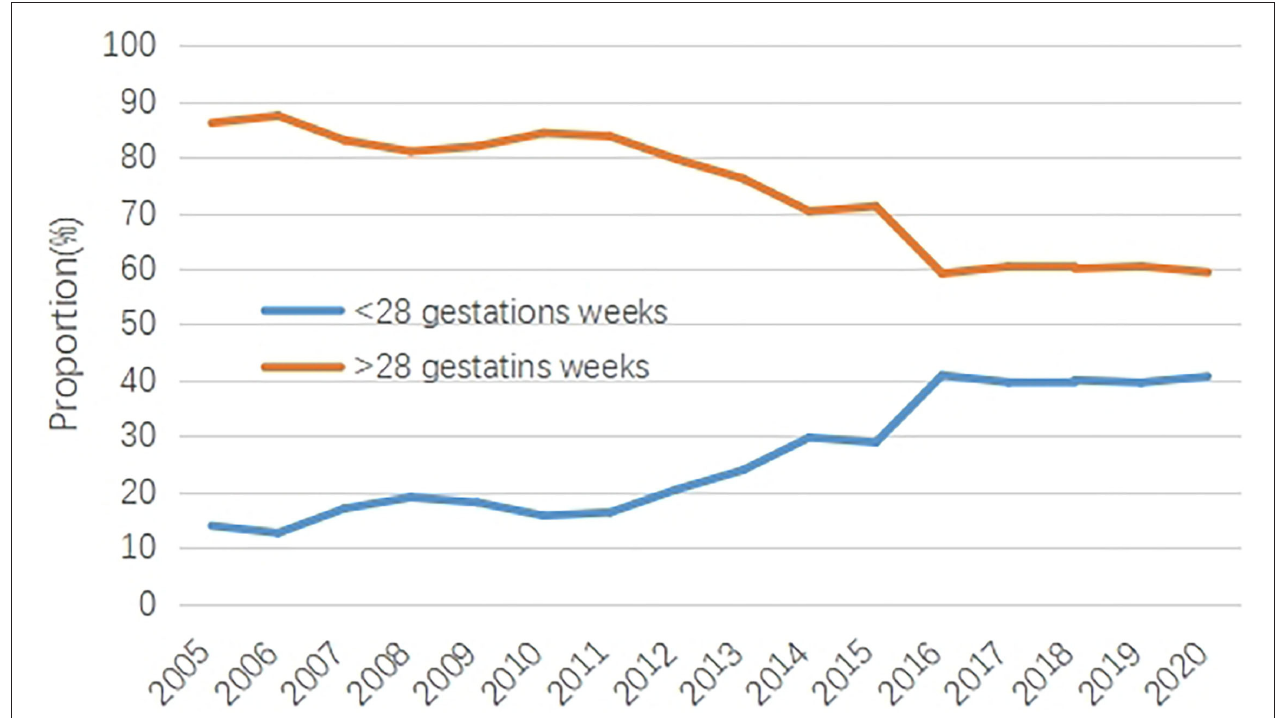
FIGURE 2 | The proportion of CHD before 28 gestation weeks and after 28 gestation weeks from 2005 to 2020.